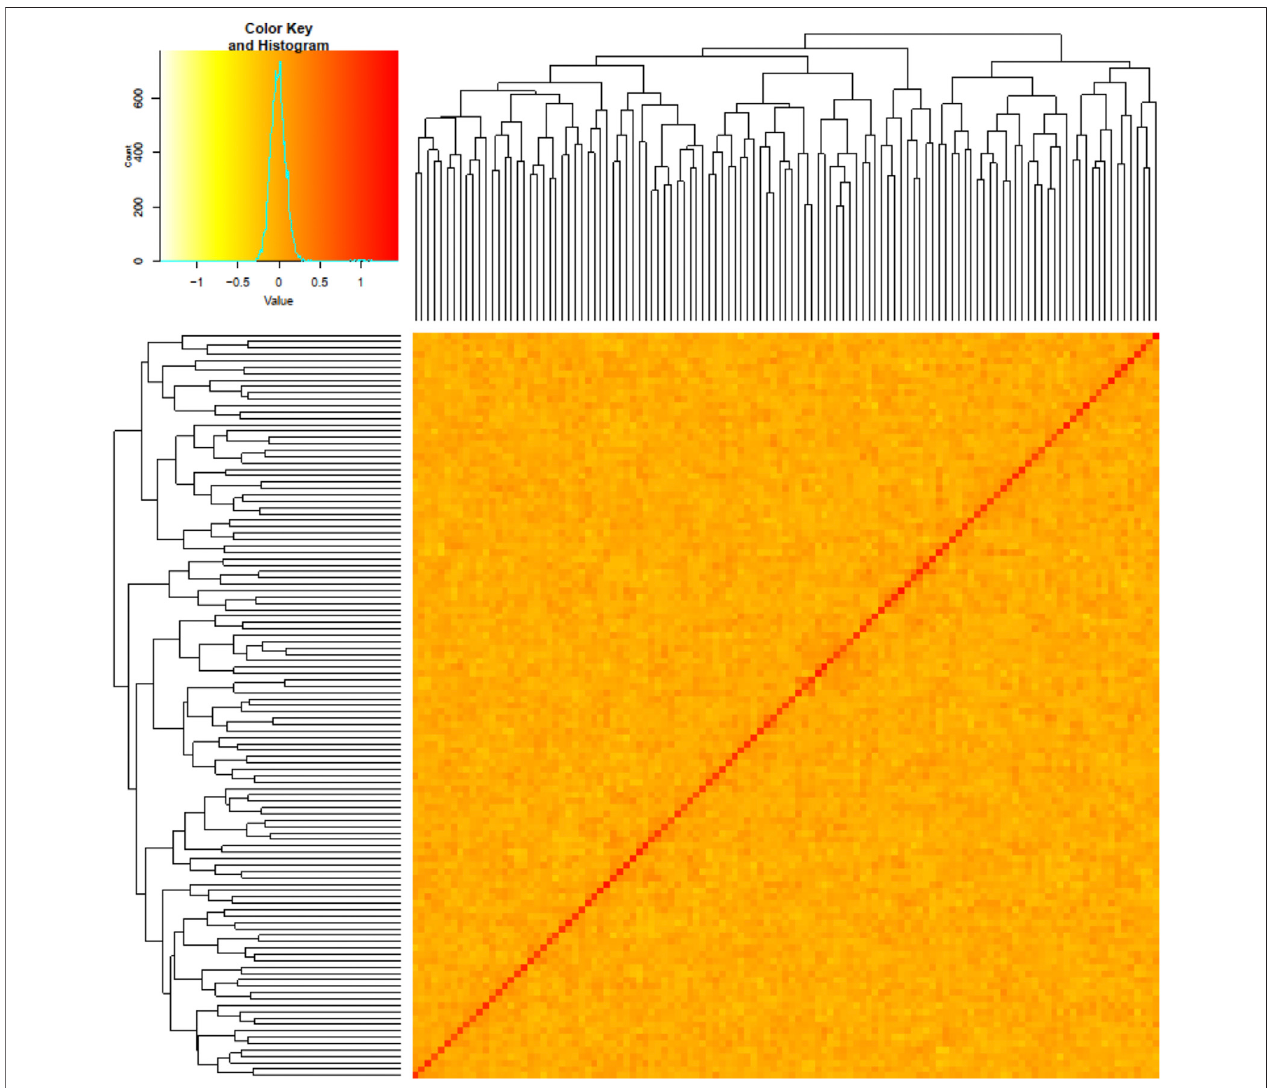
FIGURE 2 | Kinship matrix for 117 samples with darker colors and higher kinship values (e.g., kinship values ≥ 1 in this population) representing higher kinship betweenindividuals.The diagonal representsrelatedness valuesofeach individualtoitselfasareferenceforhigh kinshippatterns. Aphylogram ofindividualrelatedness among samples is shown on both